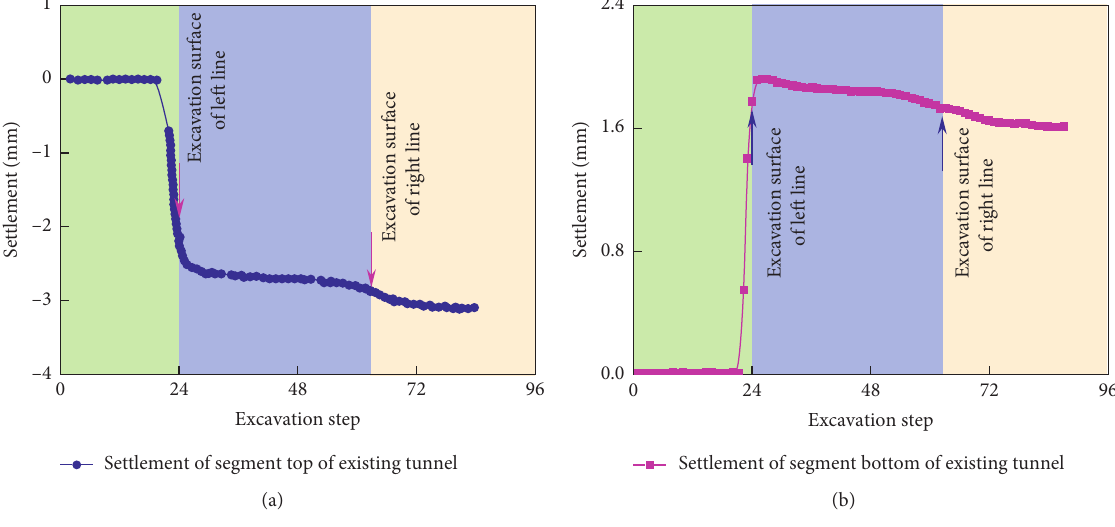
Figure 15: Development trend of settlement at segment top and segment bottom of the existing tunnel with increasing excavation step. (a) Settlement of segment top. (b) Settlement of segment